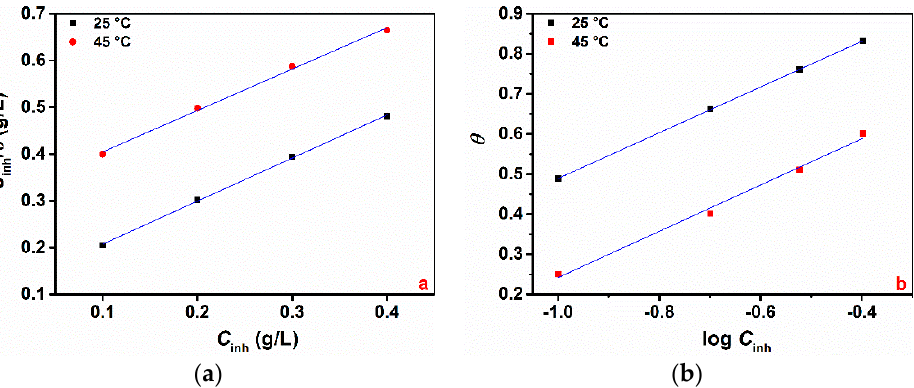
Figure 3. Langmuir (a) and Temkin (b) adsorption isotherms at 25 and 45 °C. Table 3. Parameters of the linear regression from Langmuir and Temkin adsorption isotherms at 25 and 45 °C.